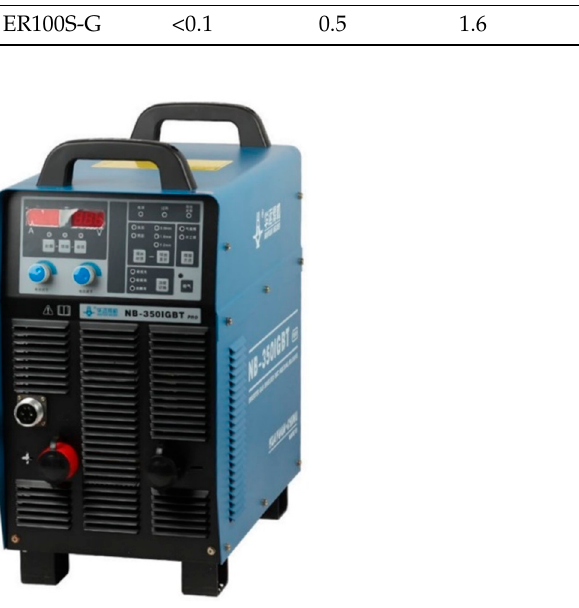
Figure 1. Welding machine .